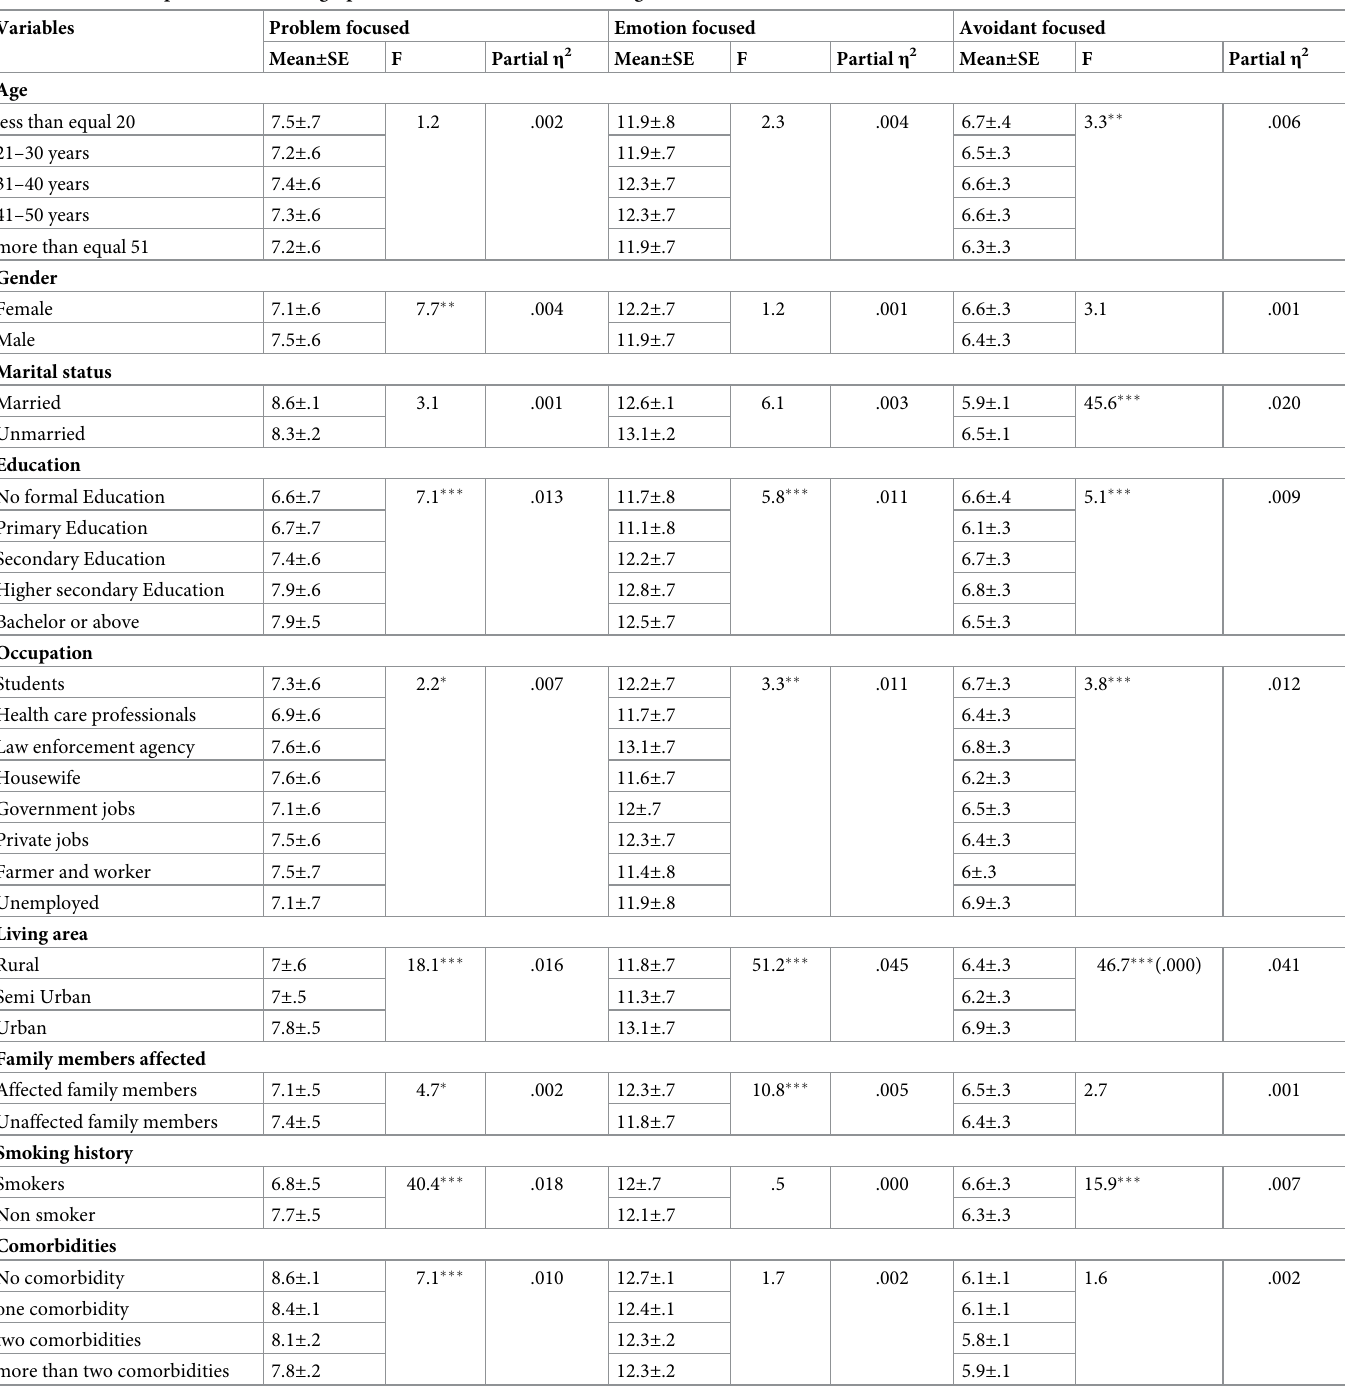
Table 3. Relationship in between demographic variables with COPING